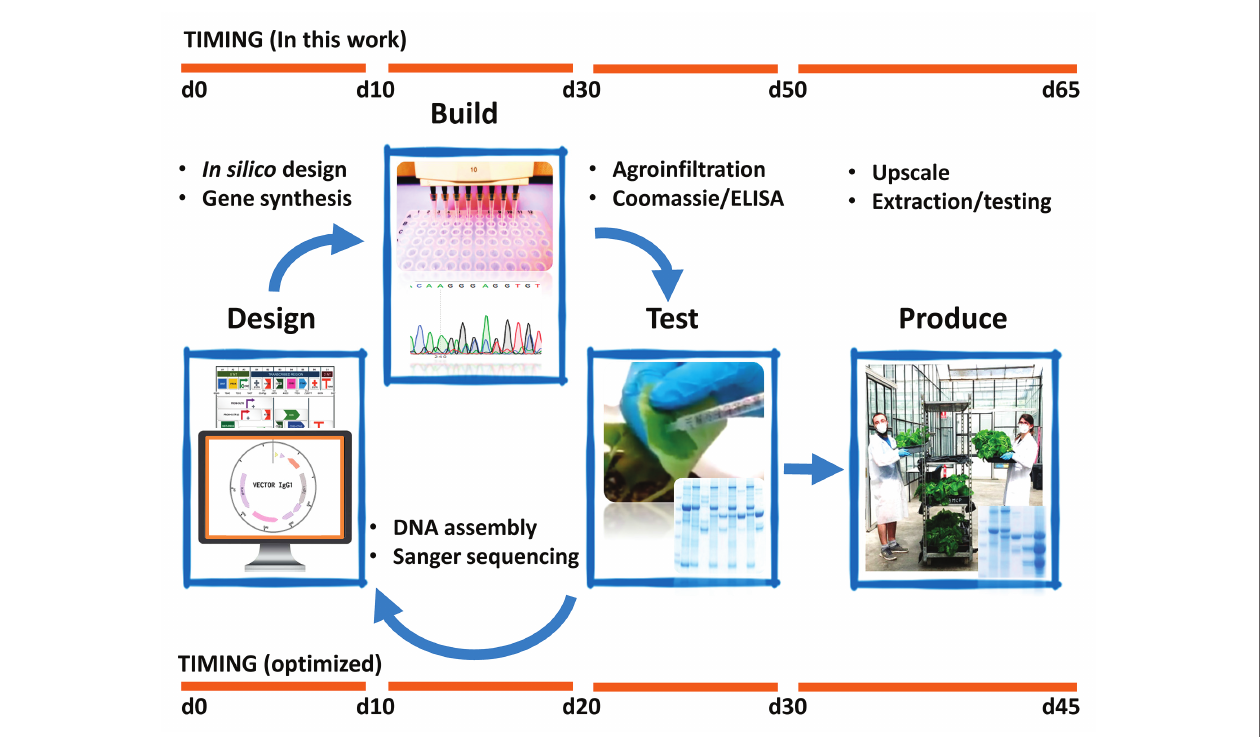
FIGURE 6 | Schematic view of the Design-Build-Test and Production pipelines employed in this work. The upper timeline represents the actual timespan of the experiments. Note that the time points represent approximately the days required to produce and initially characterize the designated products; notwithstanding, some of the results shown in previous figures correspond to extended analysis obtained at a later stage, during the preparation of this manuscript. The lower timeline describes the estimated minimal timespan that would result by introducing some of the optimizations described in the